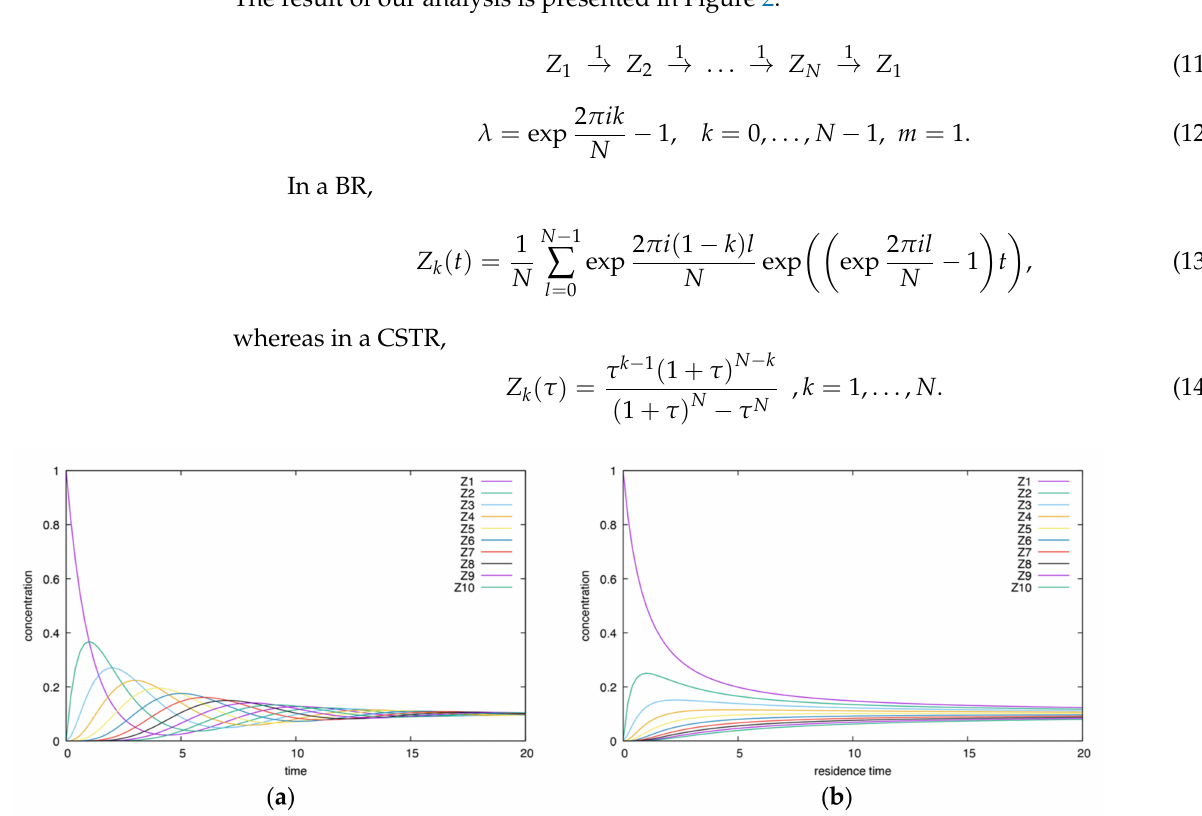
Figure 2. Evolutions in a BR ( a ) and in a CSTR ( b ) of the cyclic irreversible mechanism, N = 10. The obtained results can be used for estimating the kinetic coefficient (‘the average